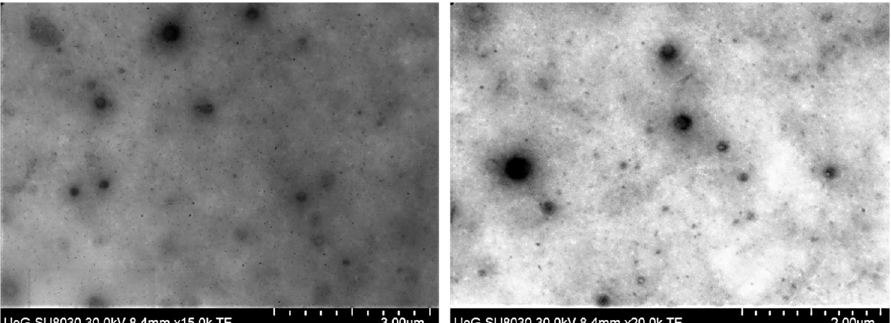
Figure 6. BF-STEM micrograph of OLZ-loaded NLCs.